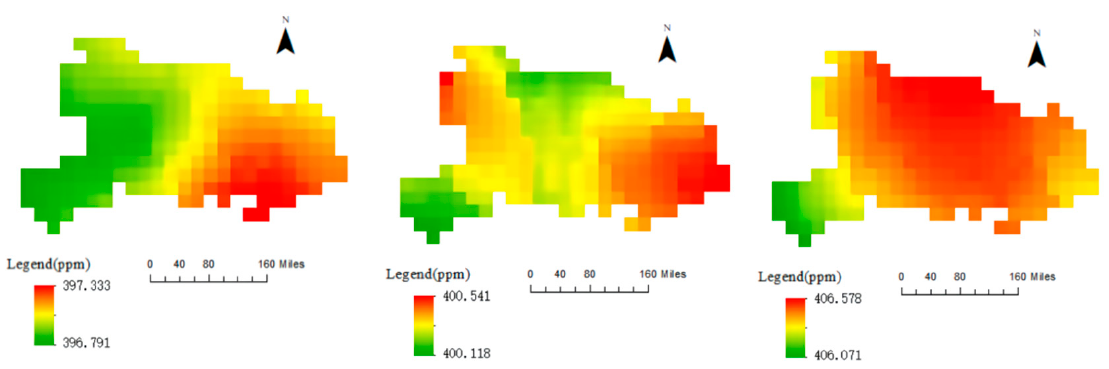
Figure 9. Spatial distribution of CO 2 concentration in Hubei province (from left to right, 2013, 2015, 2017).